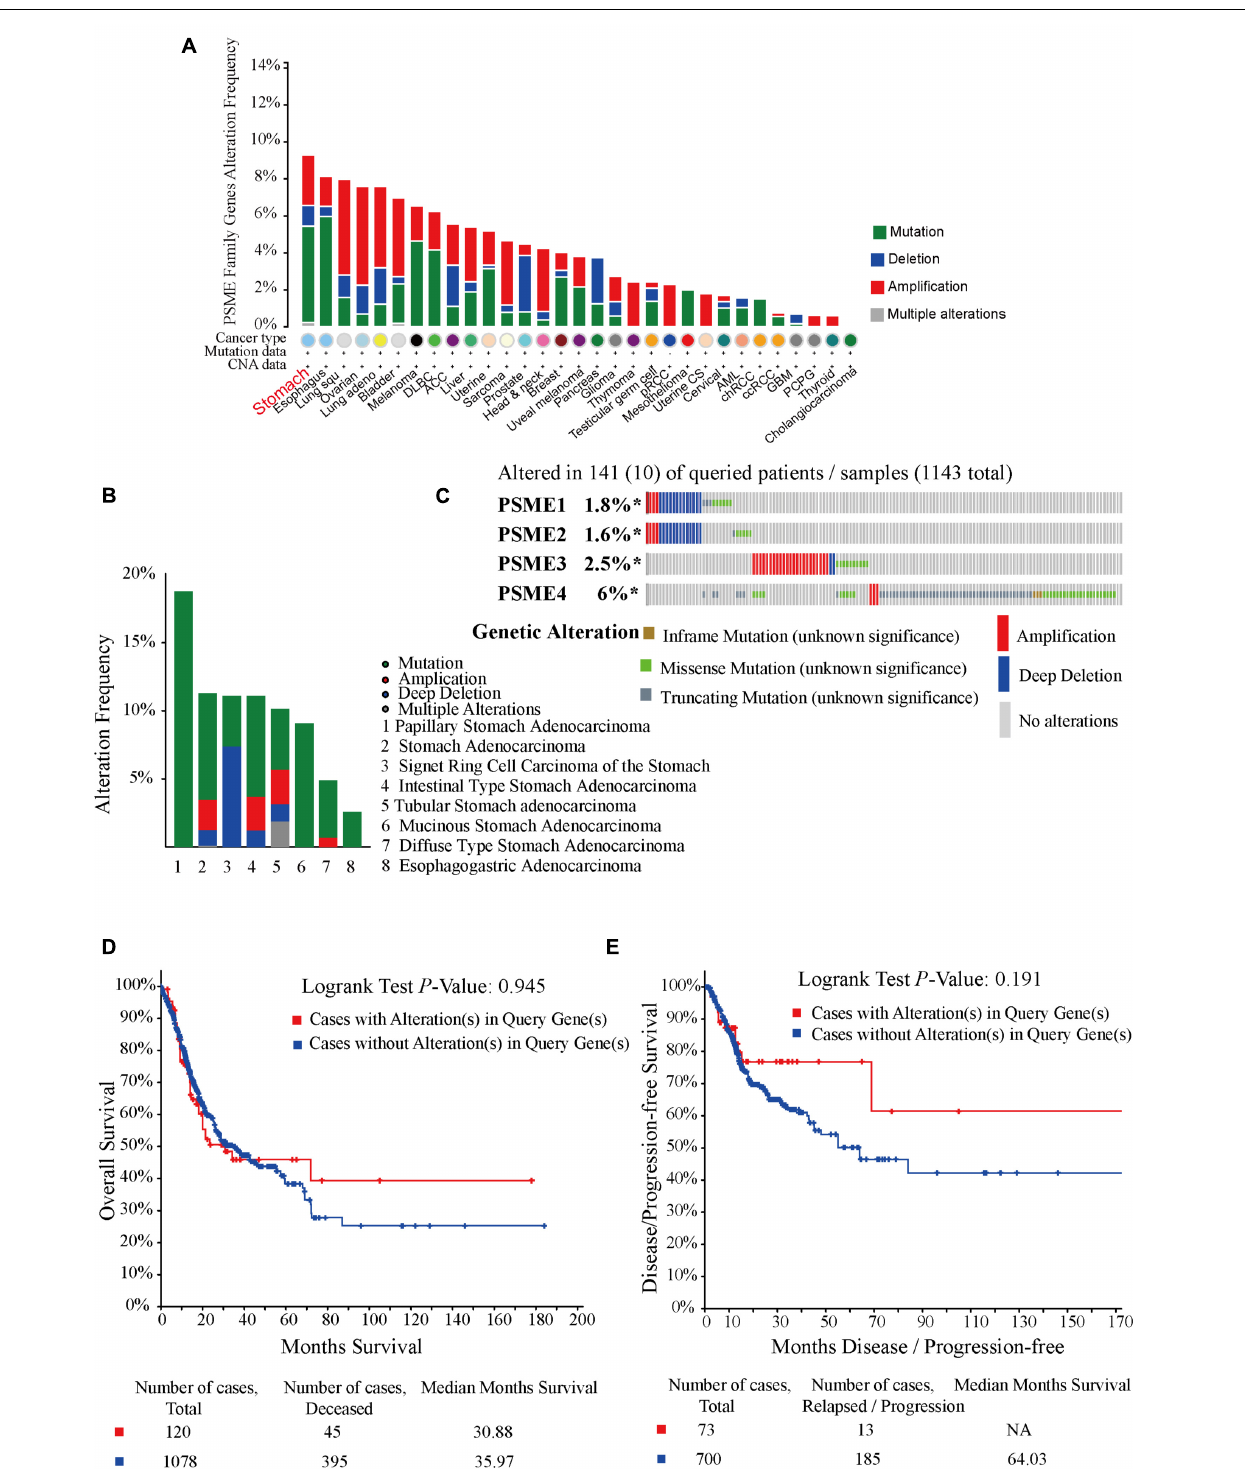
FIGURE 5 | Oncoprint and alteration differences of PSME genes in gastric cancer. (A) Summary of genetic alteration in PSME genes across all cancer types. (B) Alteration frequency plot of the PSME genes in gastric cancer with different histological subtypes. (C) The visual summary oncoprint based on a query of the PSME genes in gastric cancer. (D) Kaplan–Meier plots comparing OS in cases with and without PSME family gene alterations. (E) Kaplan–Meier plots comparing disease/progression-free survival (DFS/PFS) in cases with and without PSME gene alterations.